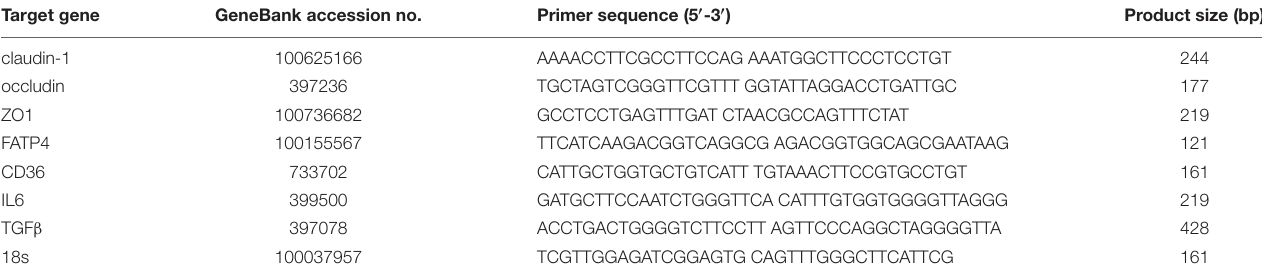
TABLE 1 | Primers used in the real-time quantitative PCR. Target gene